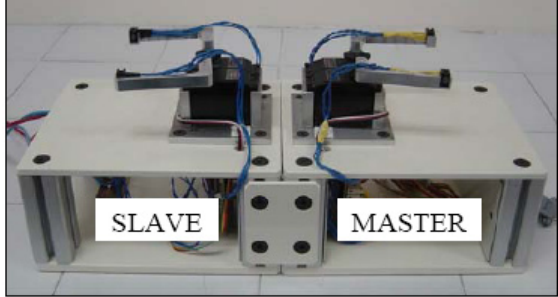
Fig.1. Master-slave haptic gripper system.